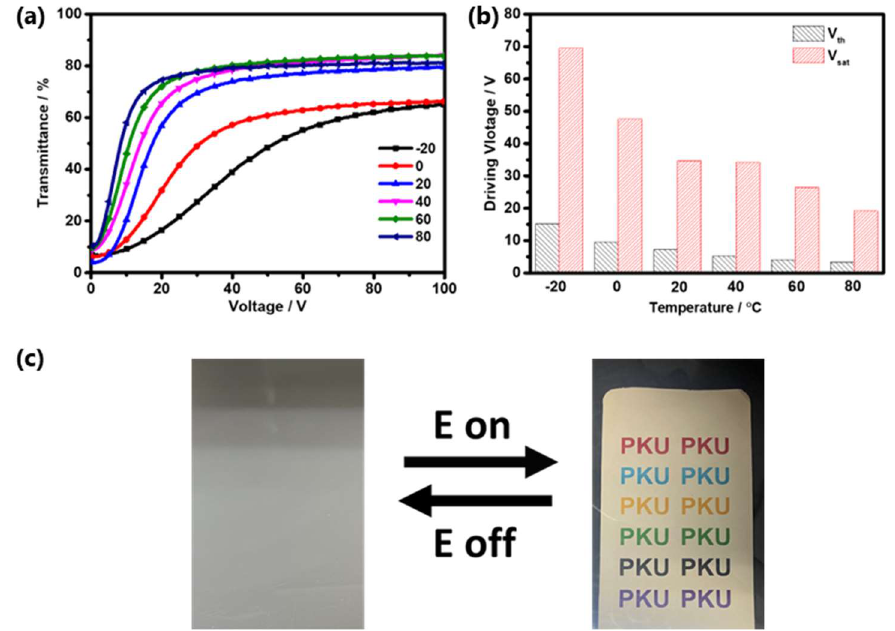
Figure 10. ( a ) Transmittance as a function of applied voltage (at 100 Hz frequency); ( b ) bar graph for threshold voltages ( V th ) and saturations voltage ( V sat ) of the PDLC film under different temperature conditions; ( c ) photo of the PDLC film in the open and closed states of the electric field.